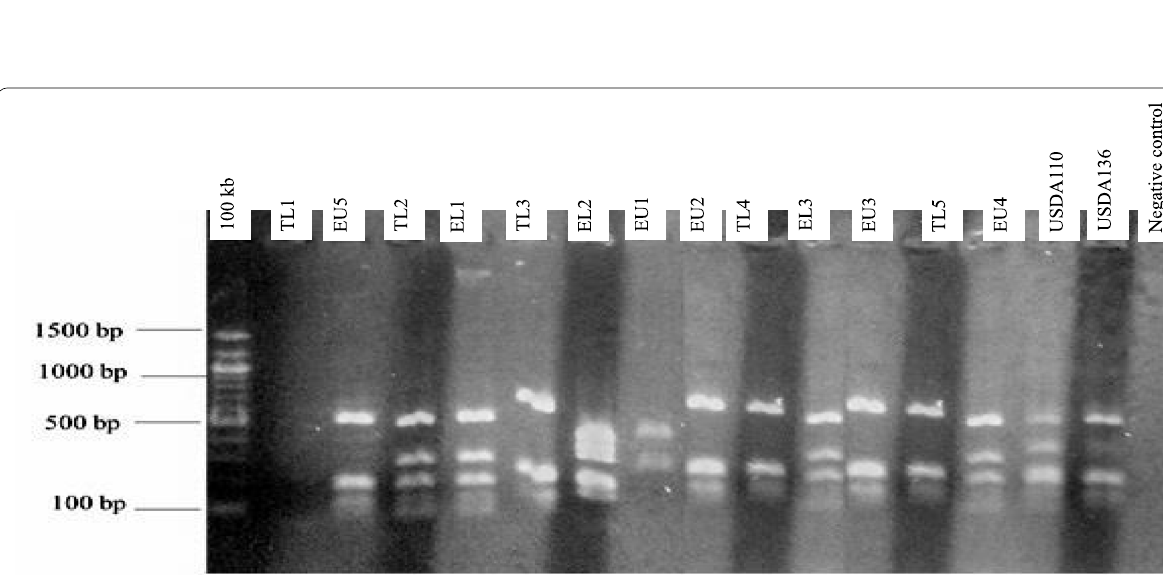
Fig. 4 Restriction fragments for bradyrhizobia isolates obtained after digestion with the Hae III enzyme on 1.4% agarose gel